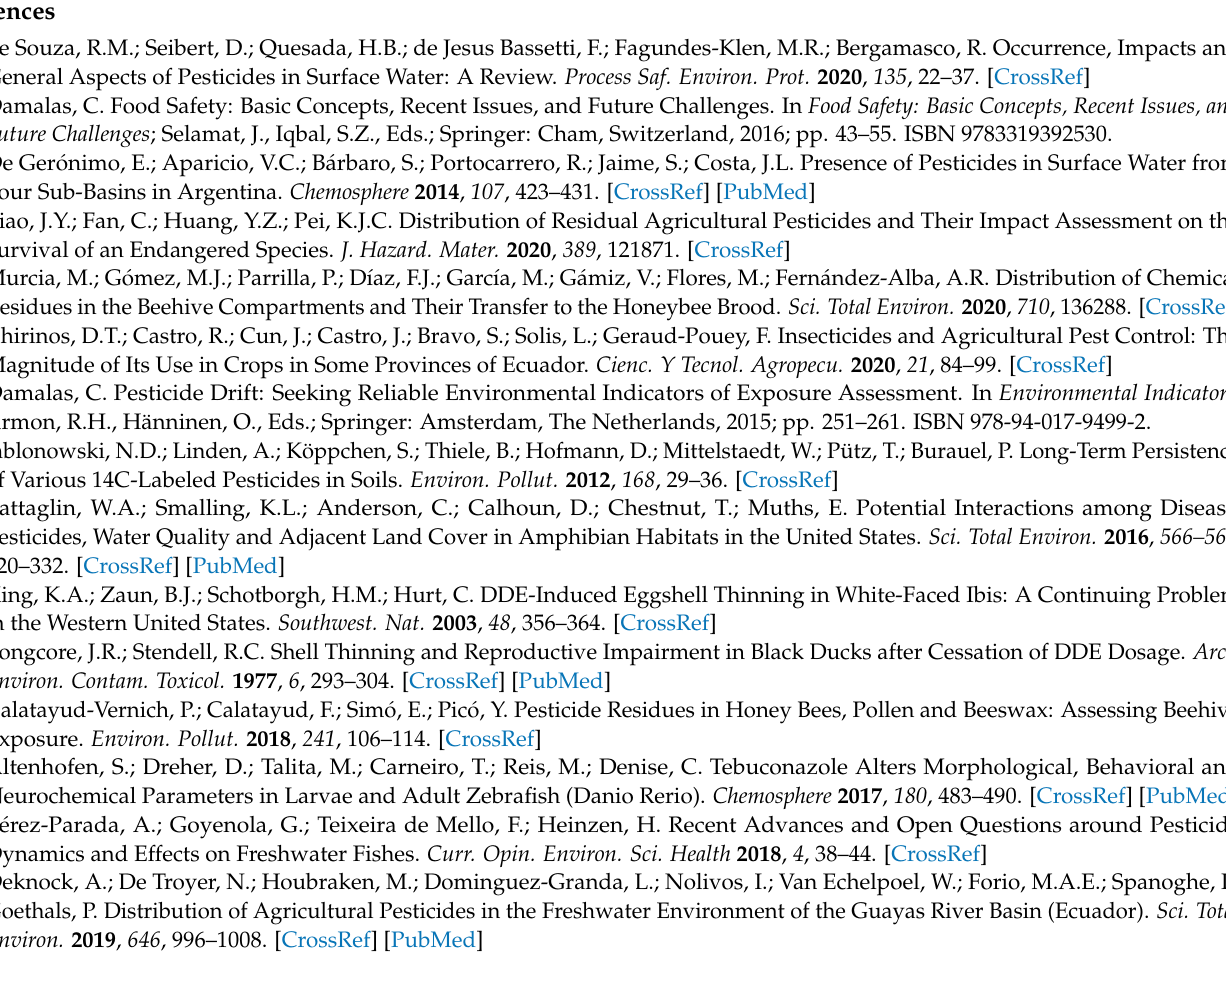
Figure A3. Variable importance explaining changes in leaf decomposition according to Random Forests.